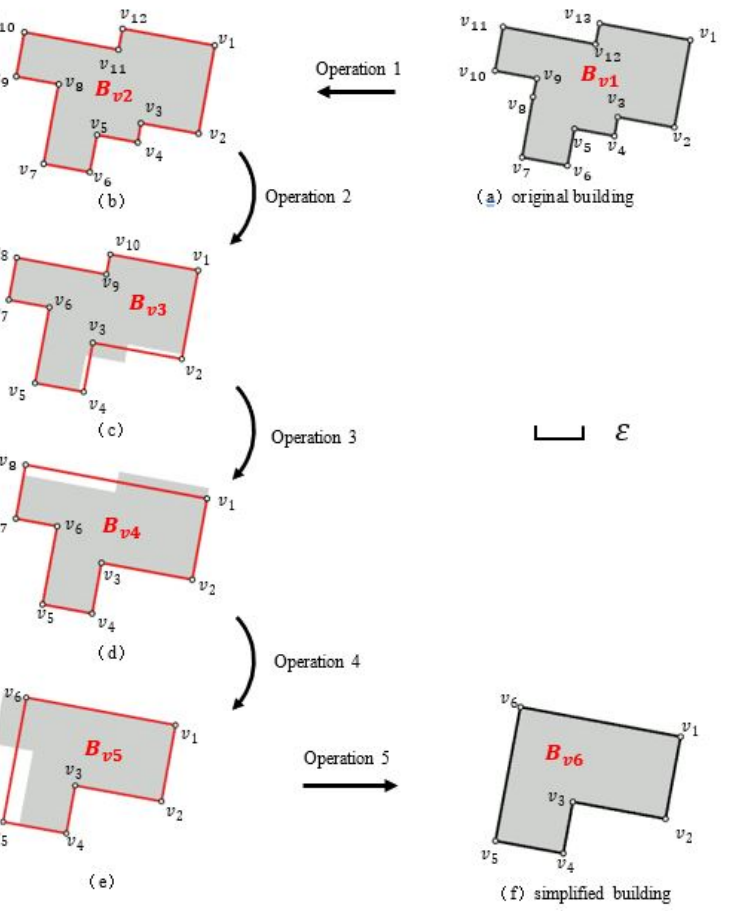
Figure 11. Example of the simplification process: ( a ) is the original building, ( f ) is the simplified building, and ( b – e ) are the process of simplification.